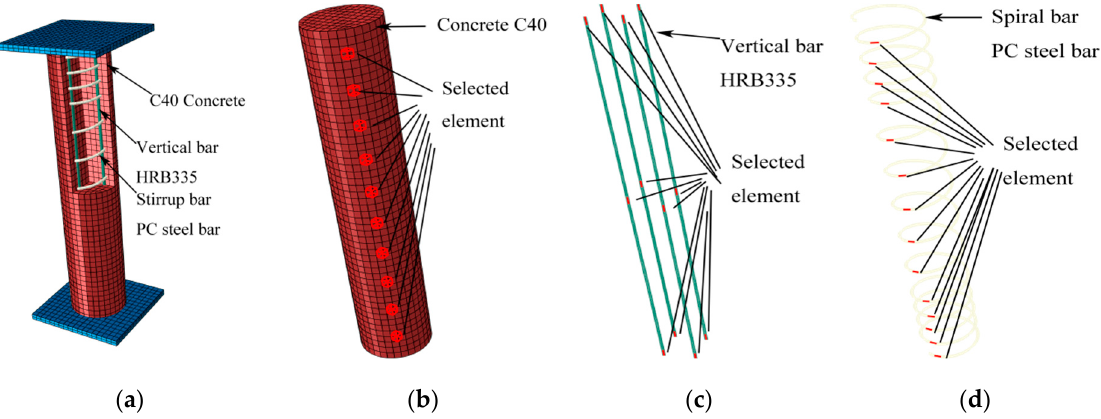
Figure 2. Meshing and element selection: ( a ) SRC column; ( b ) Concrete; ( c ) Vertical bar; ( d ) Spiral bar.